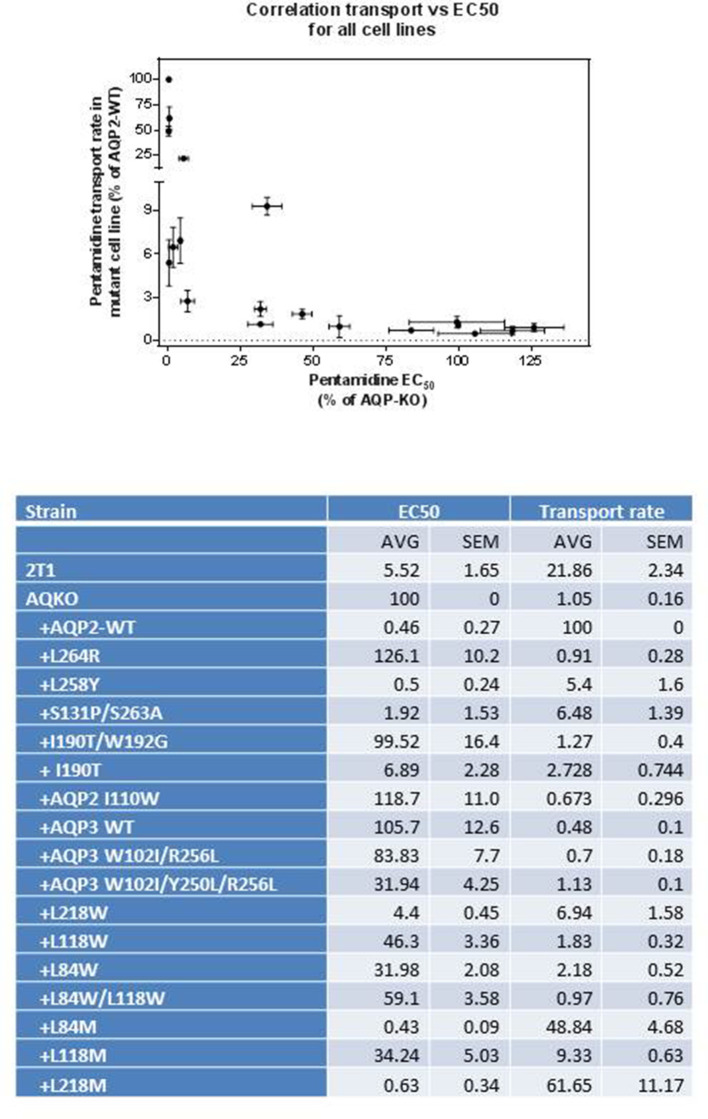
Correlation of the EC50 value with the rate of pentamidine transport for all 19 cell lines expressing a wild-type or mutant TbAQP2 in the aqp2/3 null T. b. brucei line.All EC50 values are expressed as percentage of the resistant control, aqp2/3 null transfected with an empty vector (no TbAQP2). 2T1 is the parental cell line of the aqp2/3 null. All values are the average of at least three independent determinations; the sensitive and resistant control cell lines were included in each independent experiment and the percentages taken are from the internal control rather than from the grand average over all experiments. All data for these graphs are contained in Figure 4—source data 1.